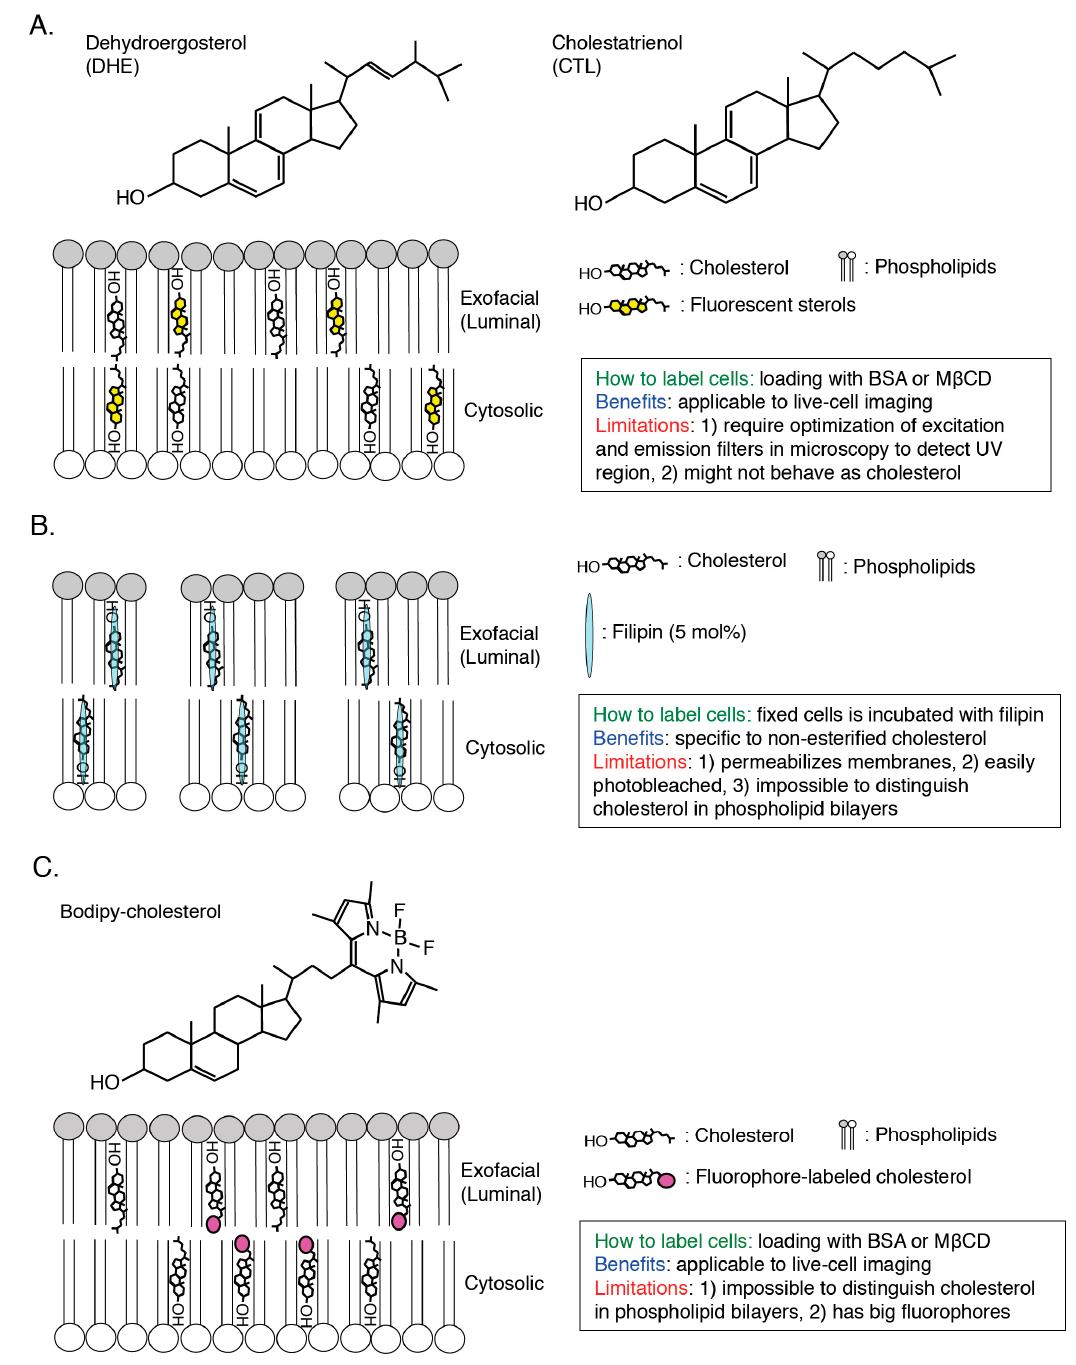
Figure 2. Scheme of visualization of cholesterol in cellular membranes by fluorescent sterols ( A ) filipin ( B ) and fluorophore-labelled cholesterol ( C ) Methodology, benefits and limitations of each cholesterol biosensor are described. Threshold for cholesterol-binding to filipin, 5 mol %, is shown ([37]; B ).